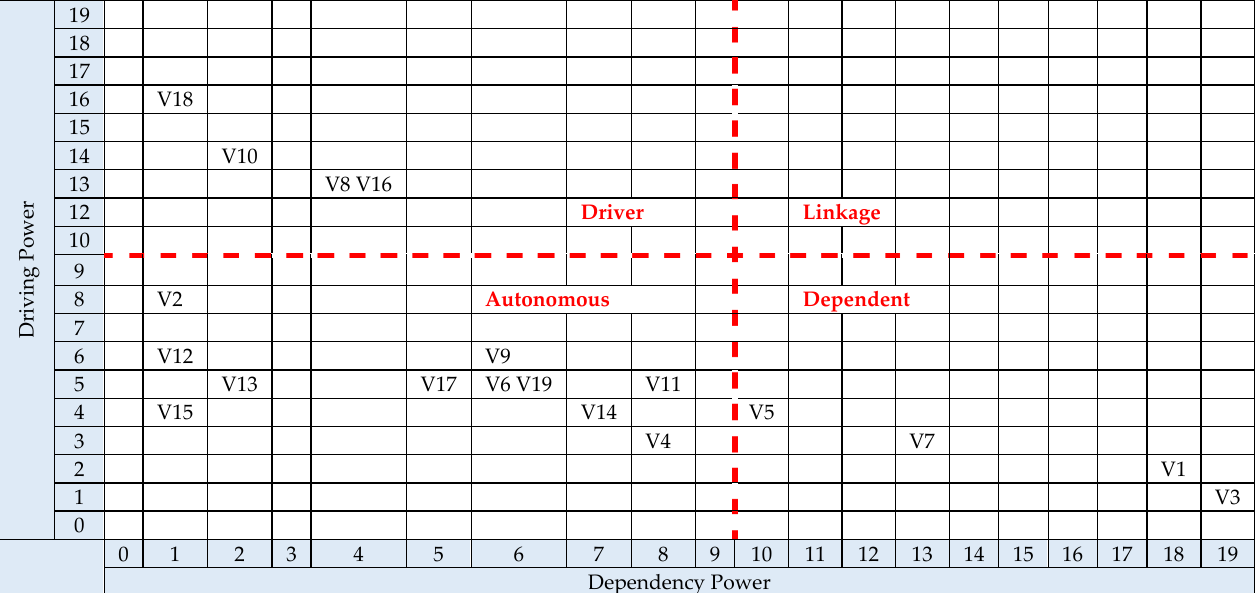
Figure 7. MICMAC Analysis.